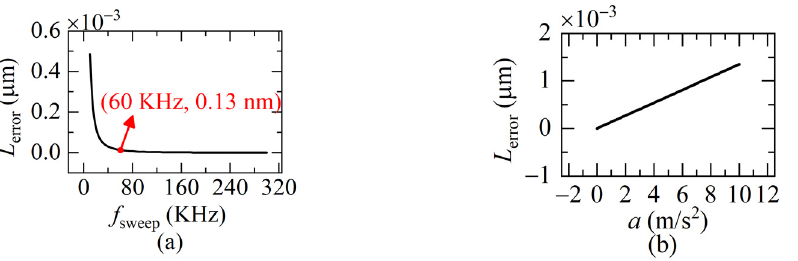
Figure 5. ( a ) The static FSI signal in one sweeping cycle ( L sta = 250 μ m); ( b ) the beat frequency result of the static FSI signal after the FFT. For a dynamic target, the interference signal can be derived by the instantaneous beat frequency f bd in Equation (6) as: {